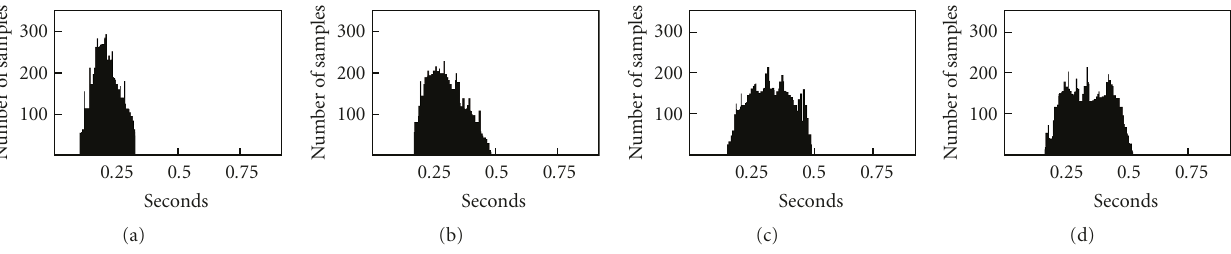
Figure 14: Response times of (a) Proposed, (b) Daugman [5], (c) Monro et al. [15], and (d) Ma et al. [7] methods using CASIA-IrisV3 database.